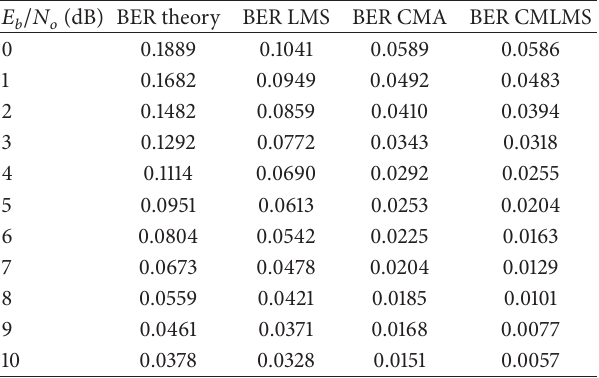
Table 3: BER performance